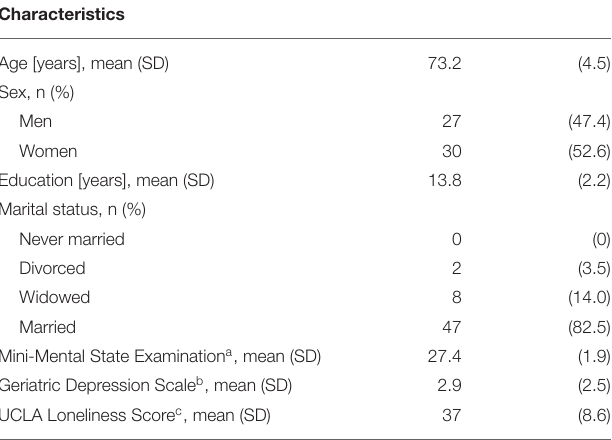
TABLE 1 | Characteristics of study participants ( N =57). Characteristics